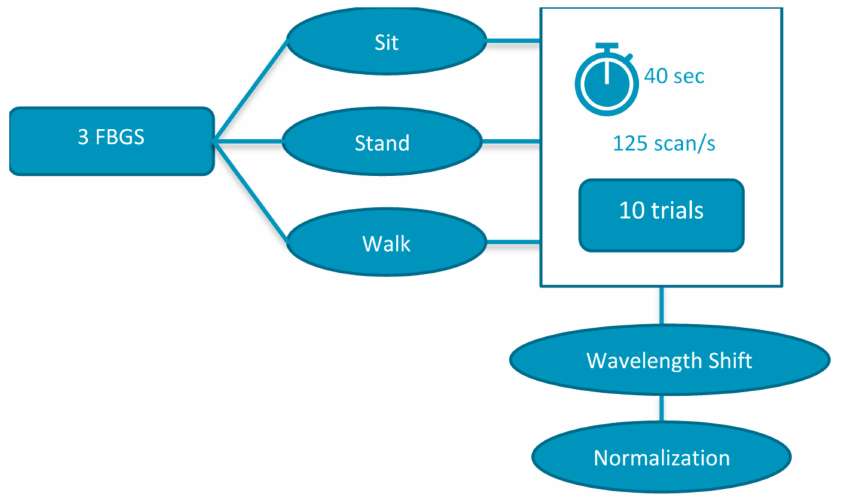
Figure 20. Schematic for part II of the experiment with FBG data collection (BCI Prediction). The participant sat in a chair of height 50 cm while wearing the BCI device correctly and resting his feet on a board where the sole is attached after taking off his shoes. This setup was designed to take the sitting data for 60 s for each of the four participants, each repeated 10 to 12 times for a total of 43 sitting data files. For the standing data, 60 s were recorded, and repeated 10 to 15 times for a total of 51 files. The walking data were recorded for 15 s repeated 20 times for each of the three participants for a total of 60 files, where the path allows for an average of 14 steps. Figure 21 illustrates (a) walking, (b) standing, and (c) sitting postures of the participants while wearing equipment.